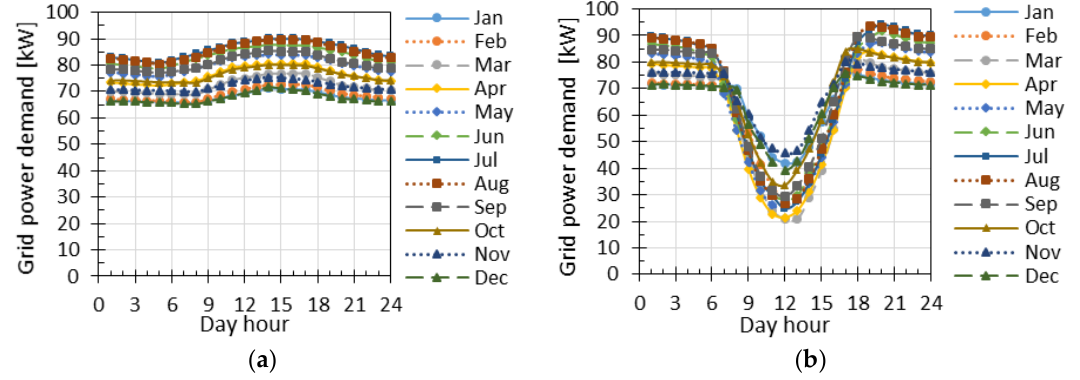
Figure 8. Grid power demand ( a ) without and ( b ) with PV plant.